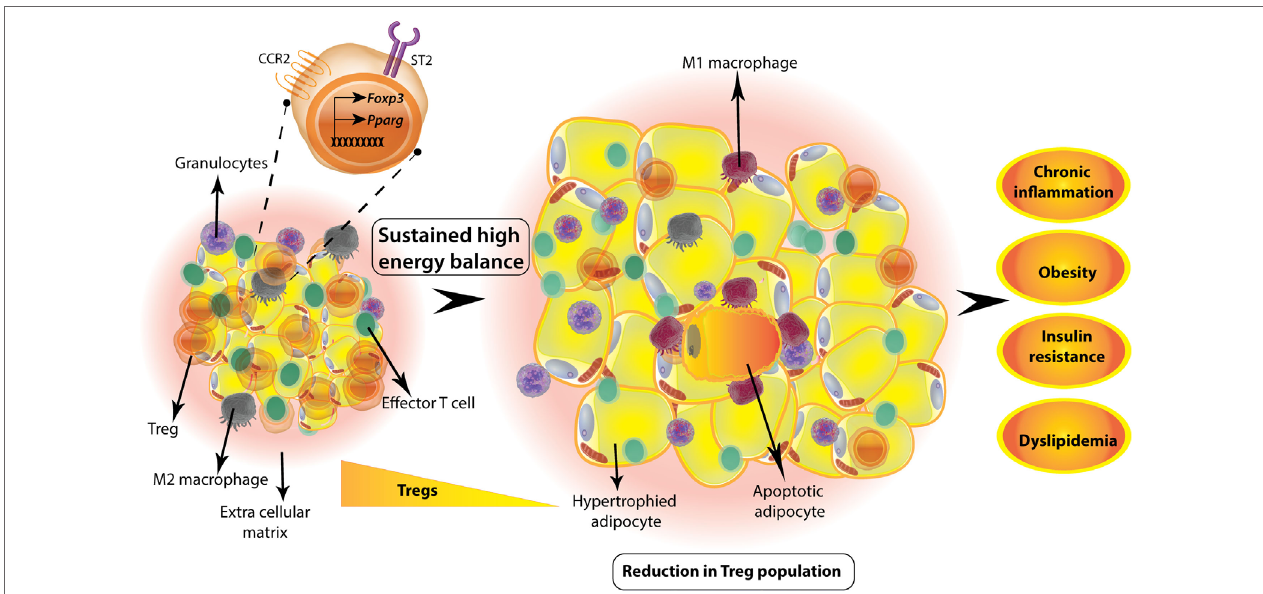
FiGURe 1 | Visceral white adipose tissue (WAT) regulatory T-cells (Tregs) are involved in metabolic homeostasis. WAT Tregs adapt to adipose environment by expression of PPAR γ that regulates genes involved in lipid metabolism. These Tregs also express alarmin IL33 receptor ST2 and adipose chemokine receptor CCR2. Tregs are abundant in lean adipose tissue of adult mouse; however, if there is a sustained positive energy balance as in high-fat diet-induced obesity animal model, then the Treg numbers decrease drastically. This is concomitant to a change in macrophage phenotype from anti-inflammatory M2 to inflammatory